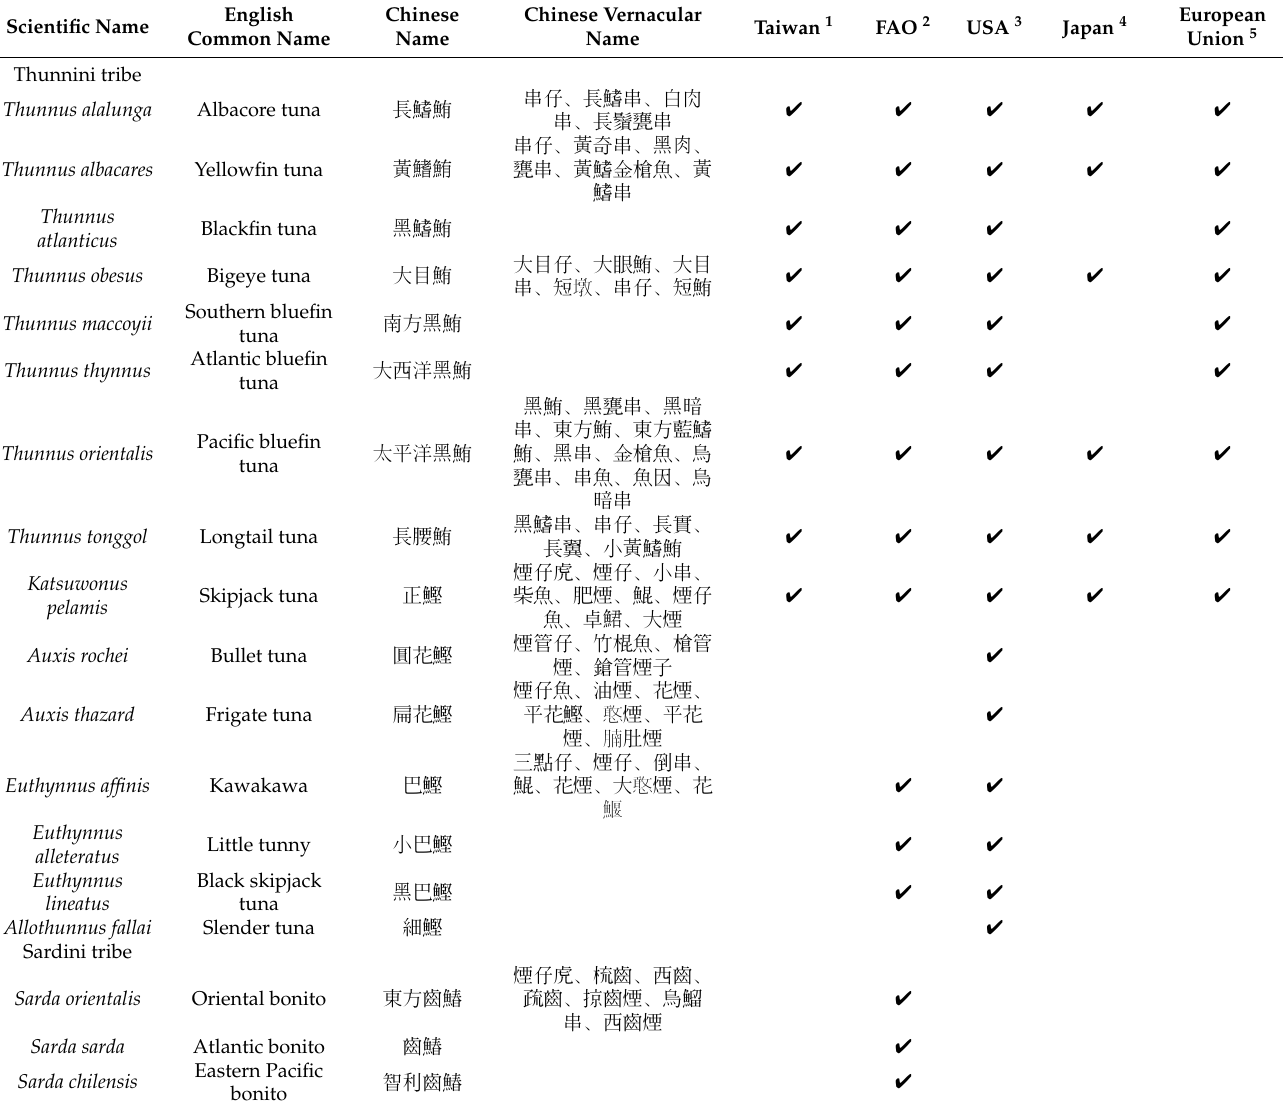
Table 1. Scientific, English common, Chinese common and vernacular names of scombrid fishes permitted by various legislative bodies as canned tuna or bonito